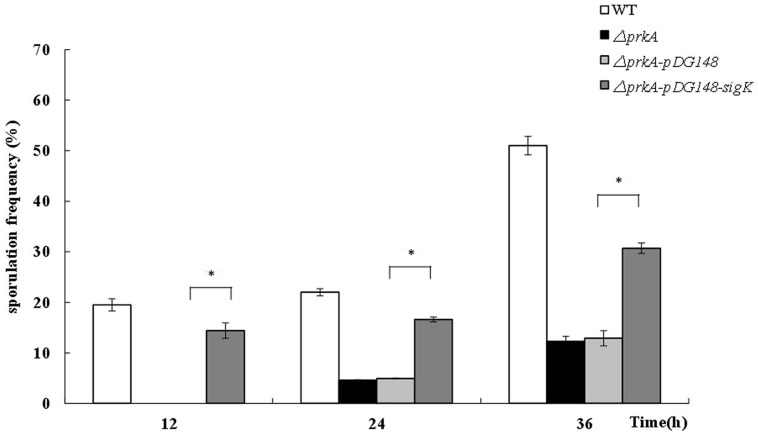
The complement of sigK gene in ΔprkA mutant strain partially rescues the effect of sporulation. Sporulation frequencies were detected in WT strain B. subtilis 168, ΔprkA mutant, the blank vector pDG148 in ΔprkA mutant, and the strain with σK complement in ΔprkA mutant. ∗P < 0.01.